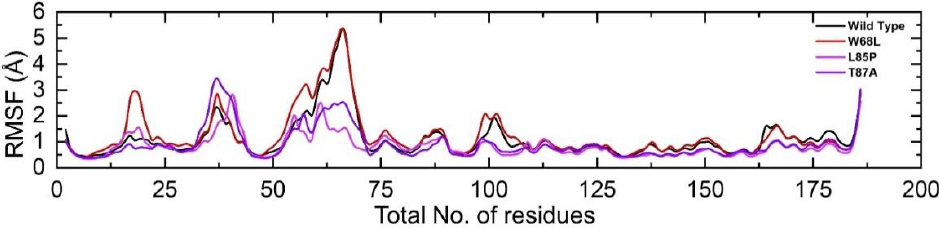
Figure 5. Residual flexibility of the wildtype and W68L, L85P, and T87A mutants. The wildtype structure is shown as black, W68L (red), L85P (magenta), and T87A (purple). structure is shown as black, W68L (red), L85P (magenta), and T87A